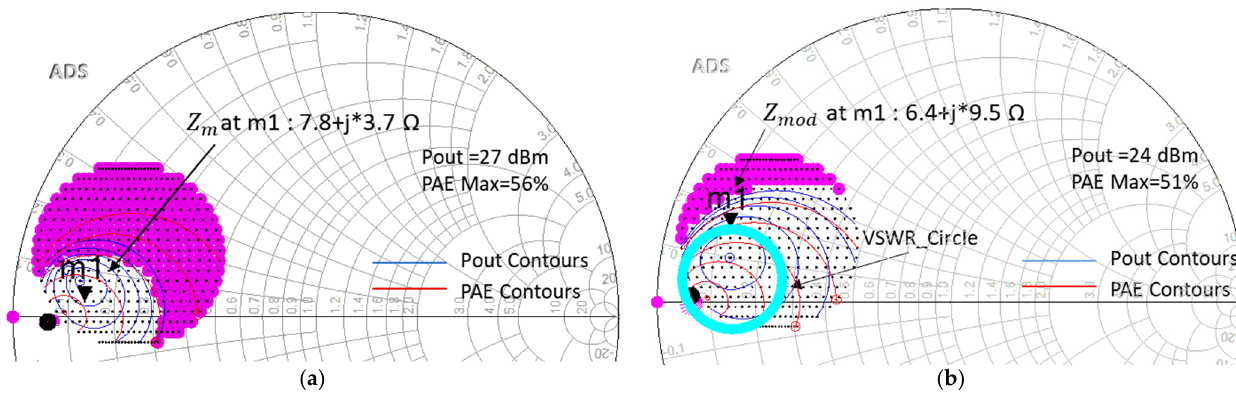
Figure 4. P out and PAE contours of the load-pull simulation dataset for the main PA ( a ) at the peak power and ( b ) at the PBO. The pink areas deliver less output power than the target at peak power (27 dBm) and at PBO (24 dBm).